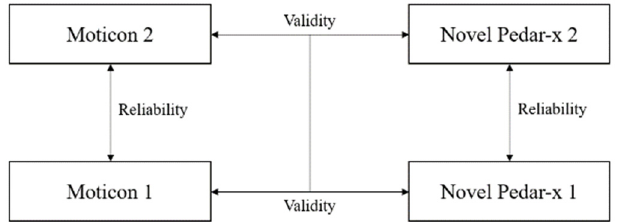
Figure 1. Randomised crossover design for assessing the reliability and validity of the Moticon sensor insoles.